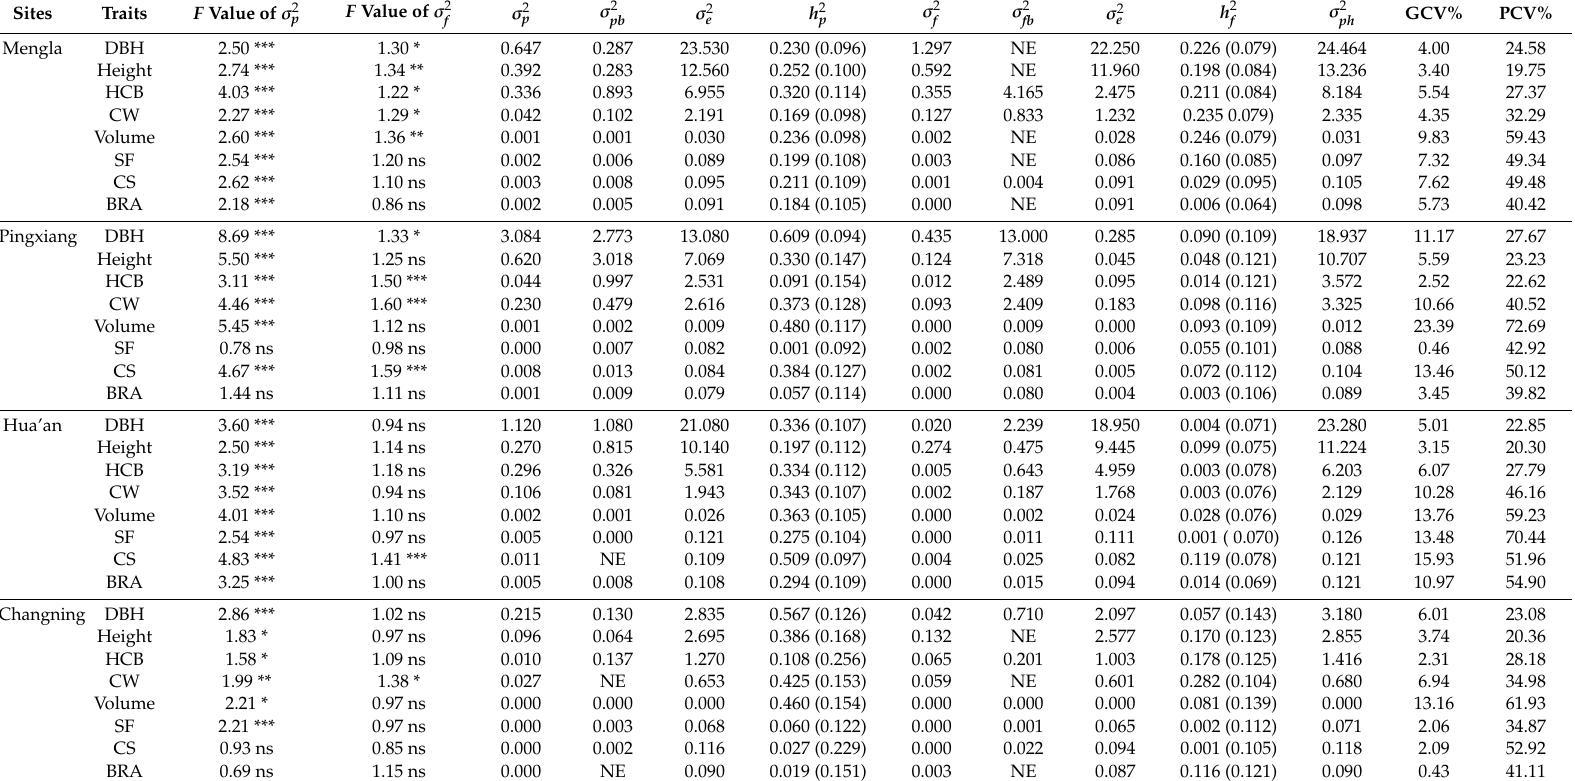
Table 4. Estimates of variances ( σ 2 p , σ 2 variance, provenance repeatability ( h 2 p ), family heritability ( h 2 phenotypic coe ffi cient of variation (PCV)) for tested traits at each